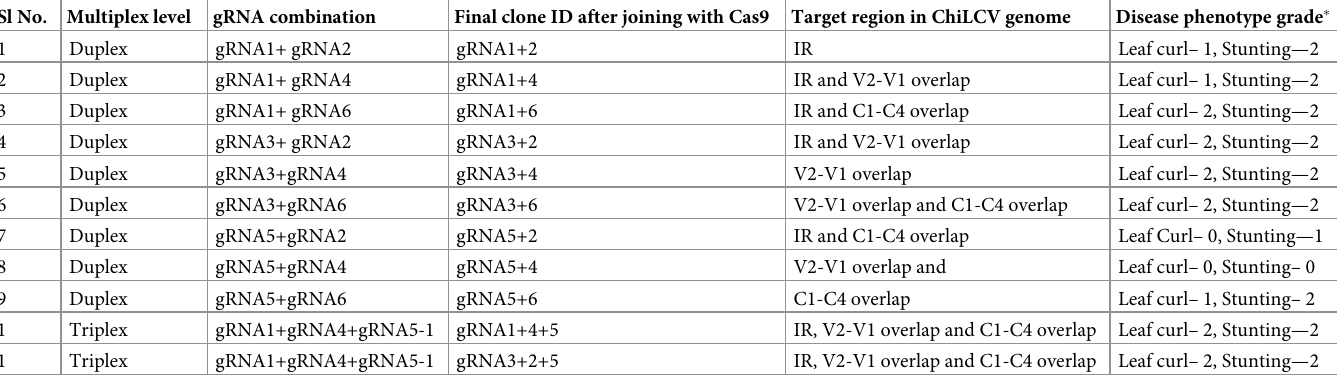
Table 4. Duplex and triplex gRNA constructs developed and their impact on disease